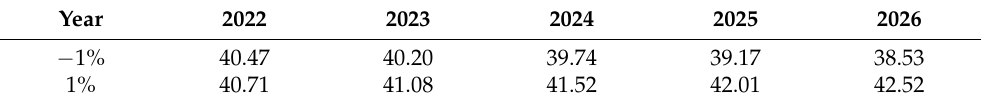
Table 11. Prediction results of water requirement with different growth rates of YEP in Beijing.